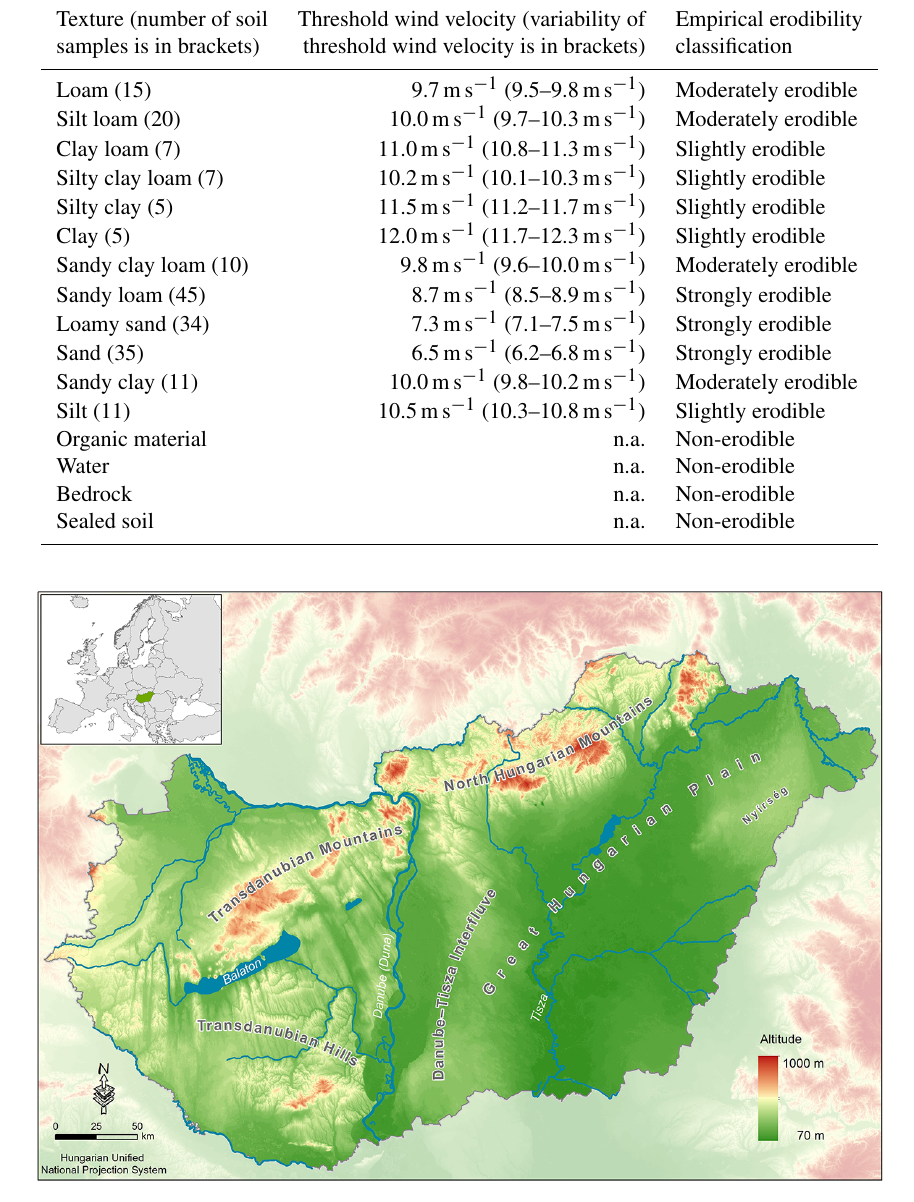
(FAO, 2006; Bakacsi et al., 2014). Some FAO categories were merged in order to increase the correlation with soil particle size